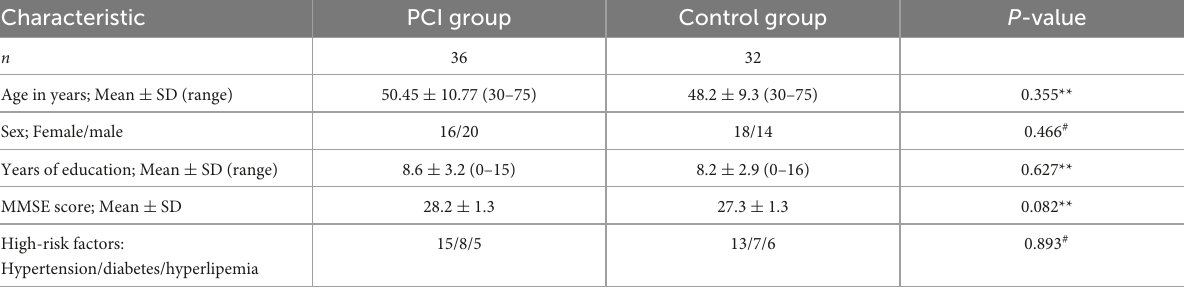
TABLE 1 Participant characteristics.